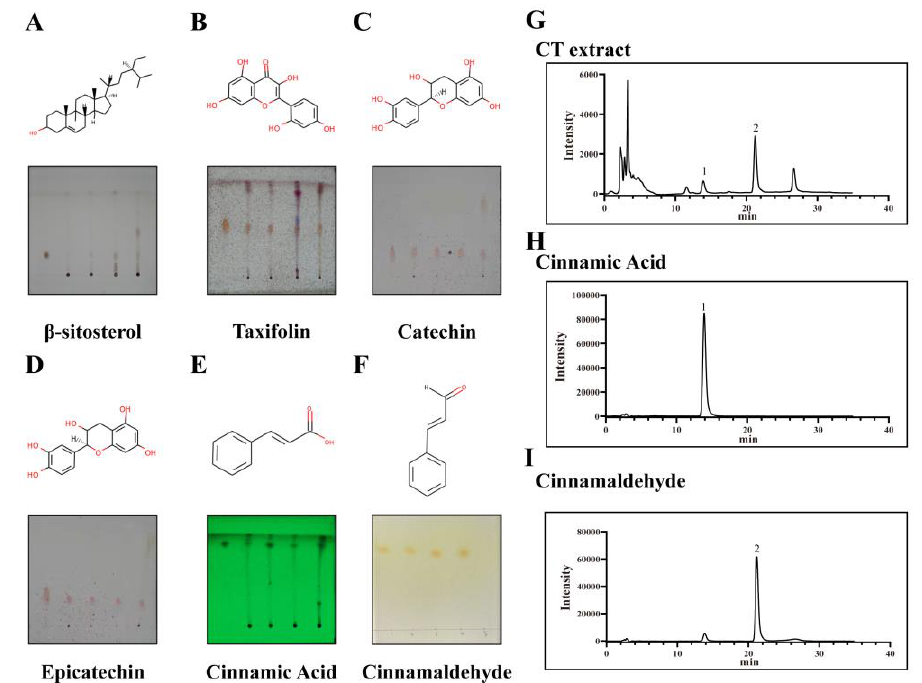
Figure 7. The ingredient identification of CT extract. TLC chromatogram and structural formula of β -sitosterol ( A ), taxifolin ( B ), catechin ( C ), epicatechin ( D ), cinnamic acid ( E ) and cinnamic aldehyde ( F ), respectively. HPLC chromatogram of CT extract ( G ), cinnamic acid ( H ) and cinnamic aldehyde ( I ). Peak 1 was the cinnamic acid response signal and peak 2 represented the cinnamic aldehyde response signal.